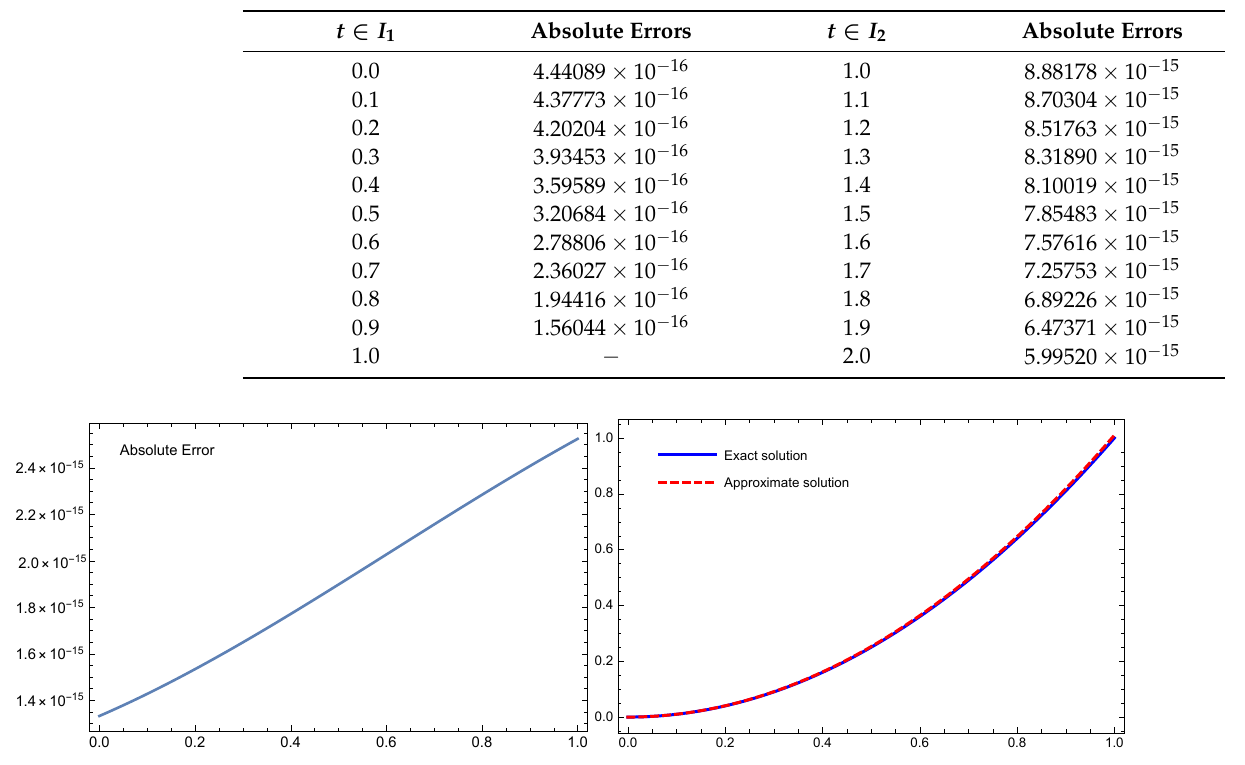
Figure 2. The exact and an approximate are shown on the right, while the absolute error is shown on the left for Example 2 where t ∈ I 1 and m =